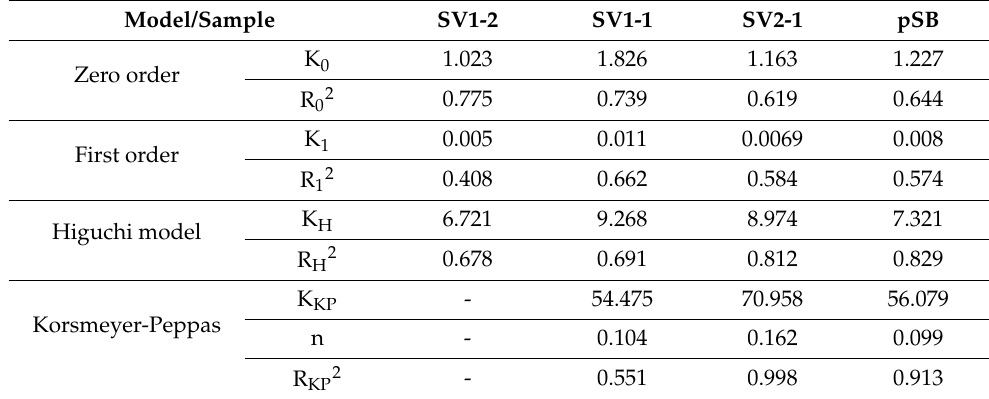
Table 4. Kinetic models describing the TM release profile from pSB-co-pVP hydrogels.